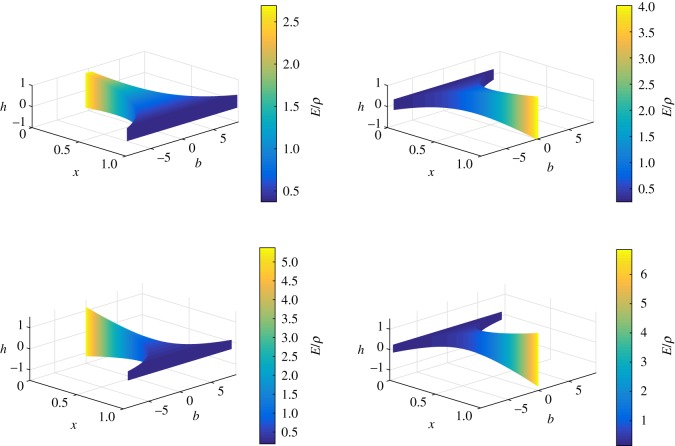
Breadth, height and ratio of modulus and density distributions of non-uniform beams isospectral to a uniform beam (Case 3: c={0.25,0.5,0.75,1}, α={−1.56155,2,−0.758306,12(5+1)}, k=−1 and r0/L=0.09).